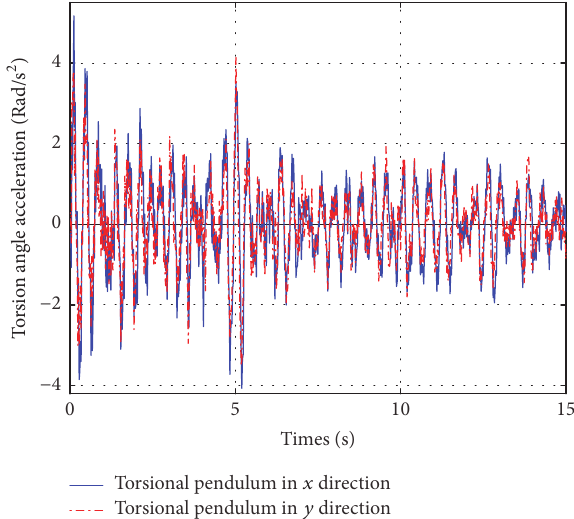
Figure 14: Acceleration history of tuned mass blocks in 𝑥 direction.